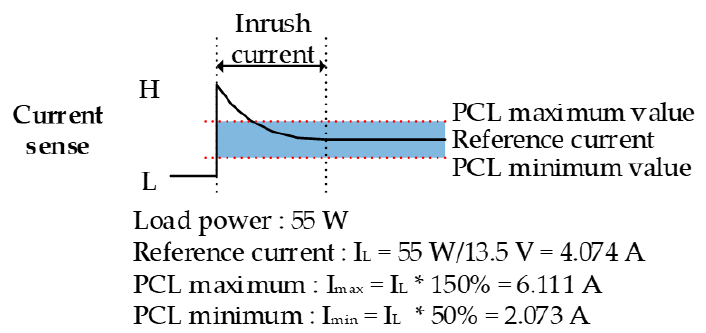
Figure 11. Configured range of the programmable current limit.